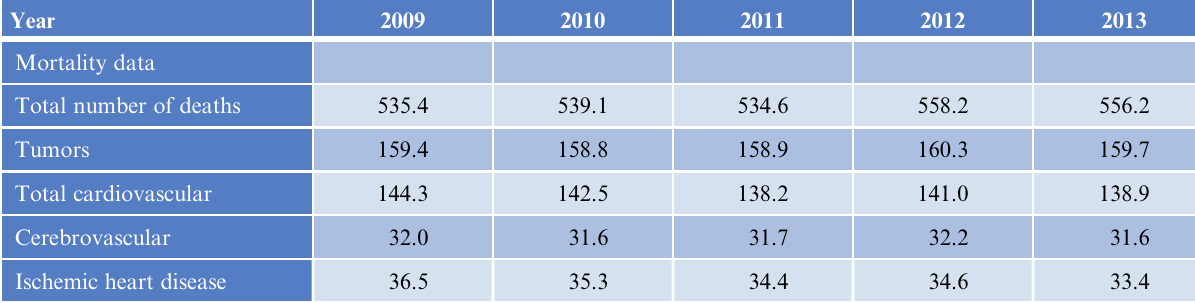
Table 1. Main causes of deaths in France, 2009 –